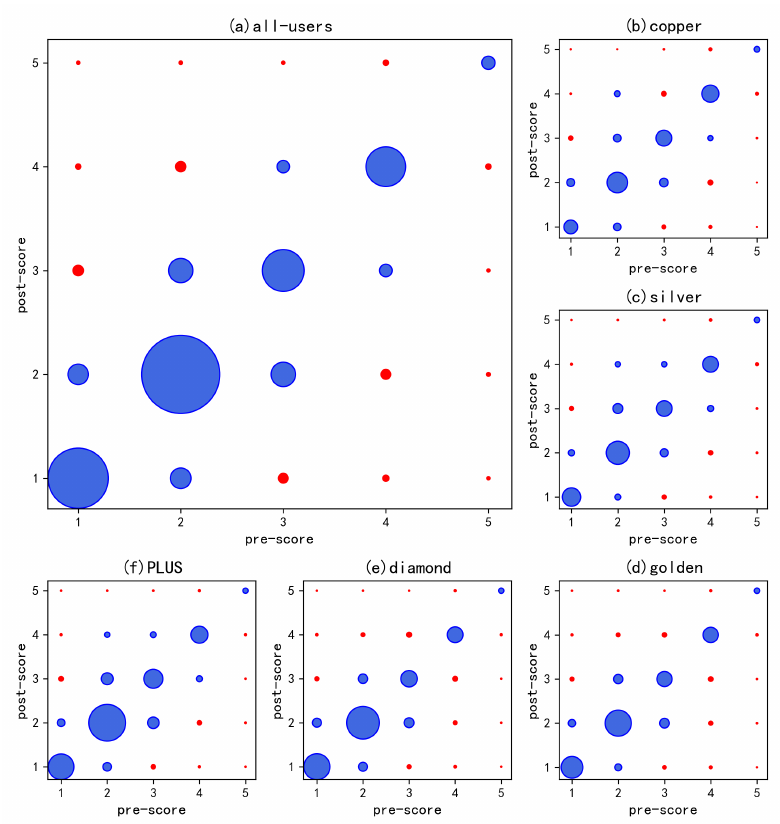
Figure 11. Normalized continuous probability for every score pair with a threshold of an hour. The x -axis and y -axis are the scores of the previous reviews and the postreviews, respectively. For every bubble, we normalized it by dividing the initial probability by the corresponding postscore’s proportion. The colored bubbles with a value larger than one are blue, and others are red. Therefore, the size, along with the color of the bubbles, represents the extent of the influence that comes from the emotional basis of previous